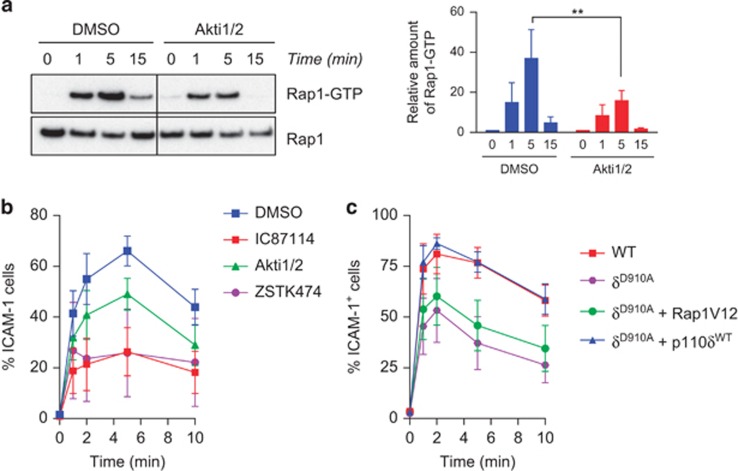
Inhibition of Akt reduces Rap1 and LFA-1 activation. (a) The active form of Rap1 was pull-down from CD4+ T cells pre-treated by DMSO or the Akt inhibitor Akti1/2. Quantification of the signal was done as in Figure 1. (b) DMSO or Akti-treated T cells were stimulated with anti-CD3 mAb in presence of scICAM-1 for the indicate times. Bound APC-labelled scICAM-1 on surface of CD4+ T cells was detected by flow cytometry. (c) WT and p110δD910A T cells transfected with constitutively active Rap1 or WT p110δ were assessed for LFA-1 binding to scICAM-1. (a–c) All data are representative of at least three independent experiments.